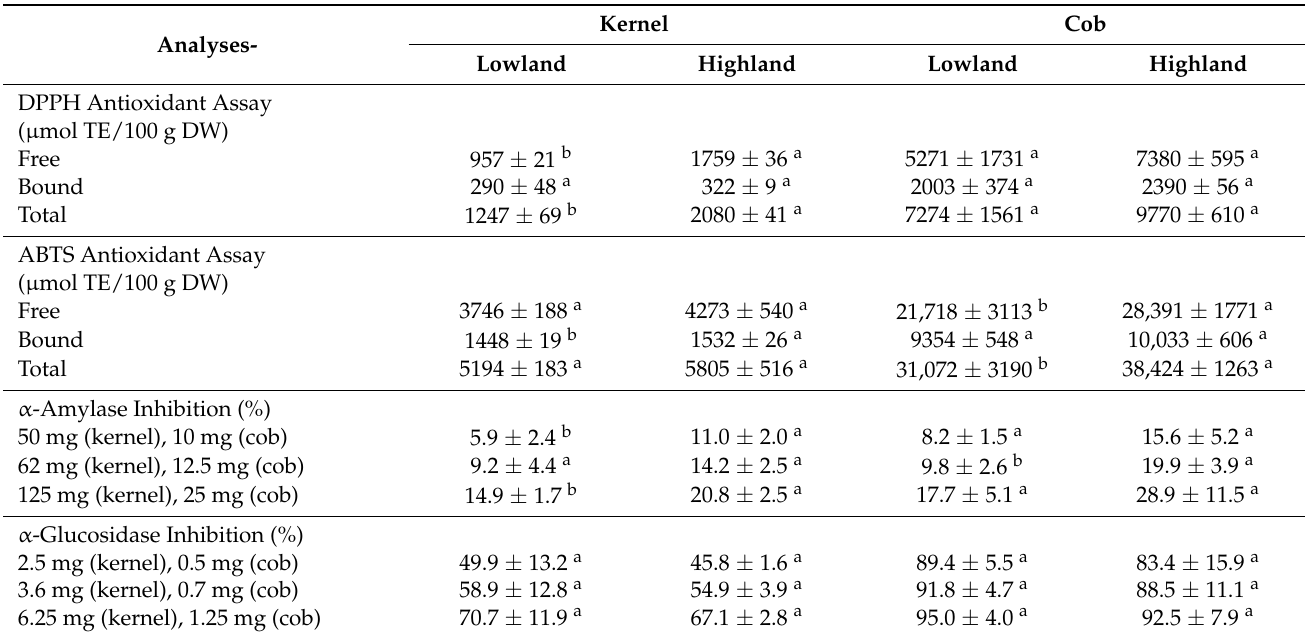
Table 3. In vitro antioxidant capacity, α -amylase, and α -glucosidase inhibition in purple corn kernel and cob from lowland and highland geographical zones in